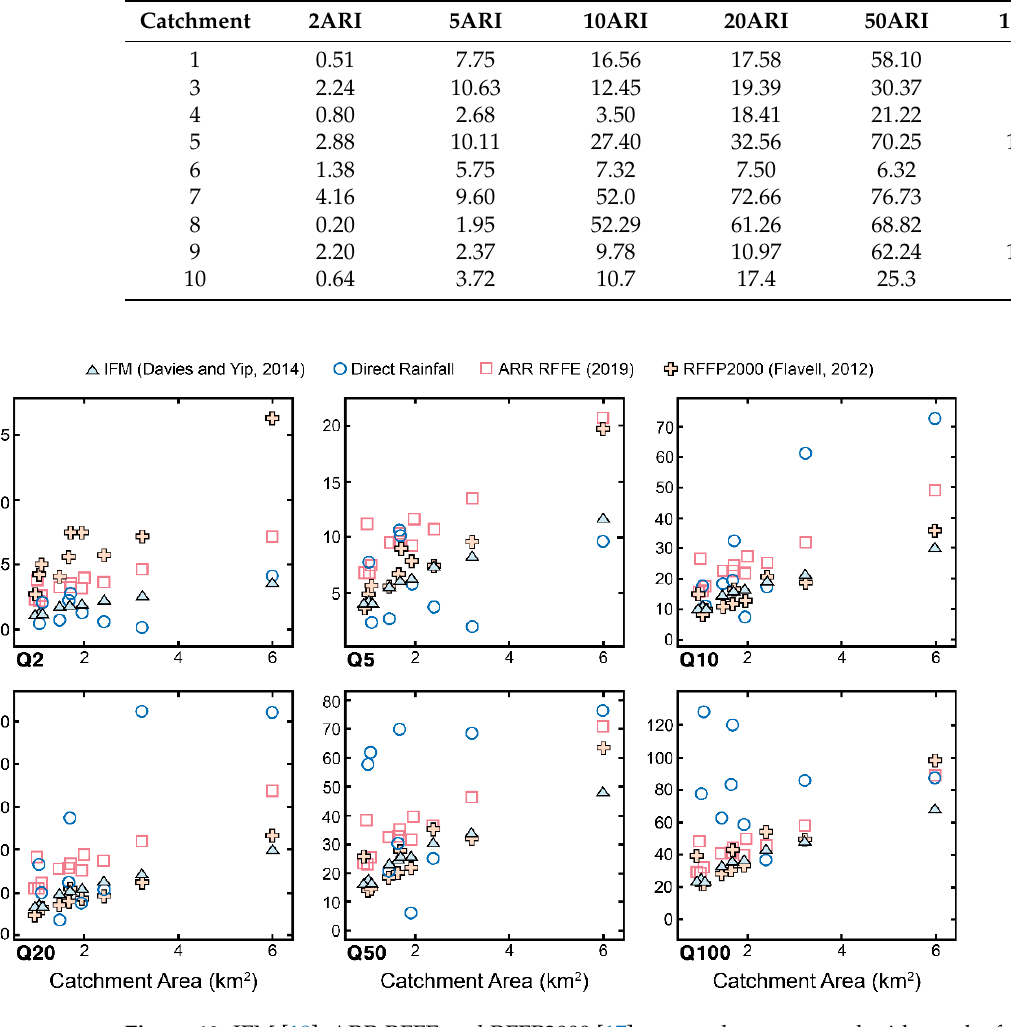
Figure 10. IFM [18], ARR RFFE and RFFP2000 [17] approaches compared with results from direct rainfall modelling from TUFLOW for the modelled headwater catchments.